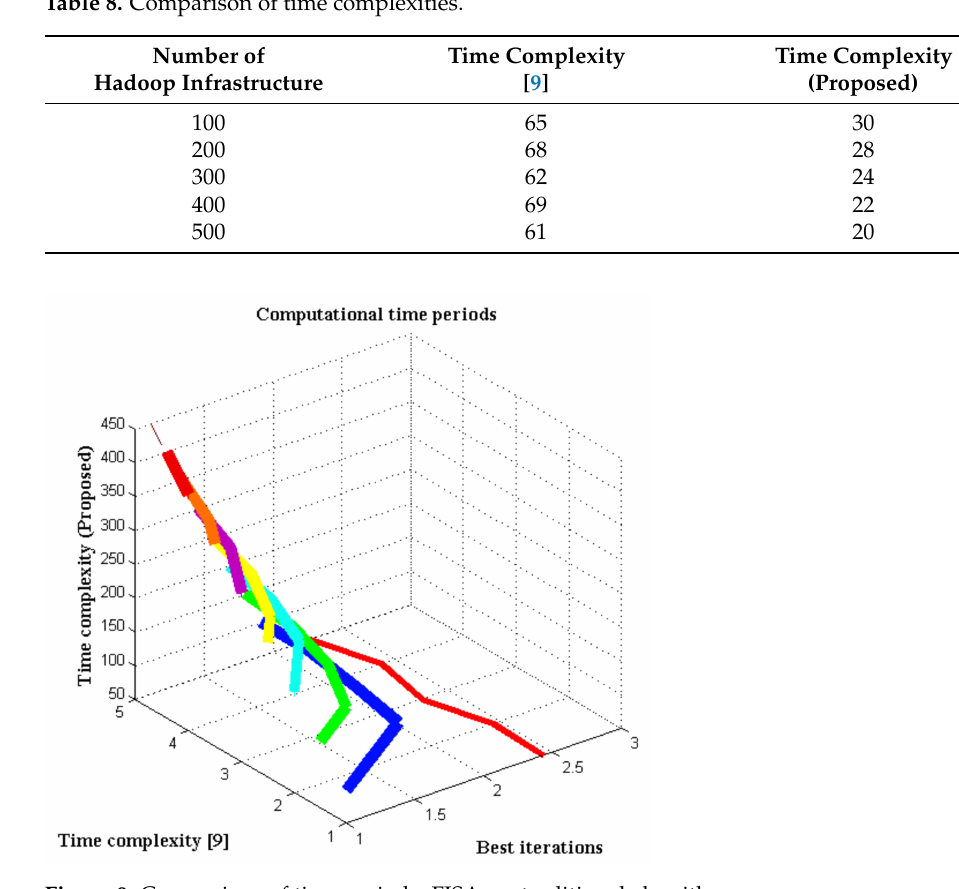
Figure 9. Comparison of time periods: FISA vs. traditional